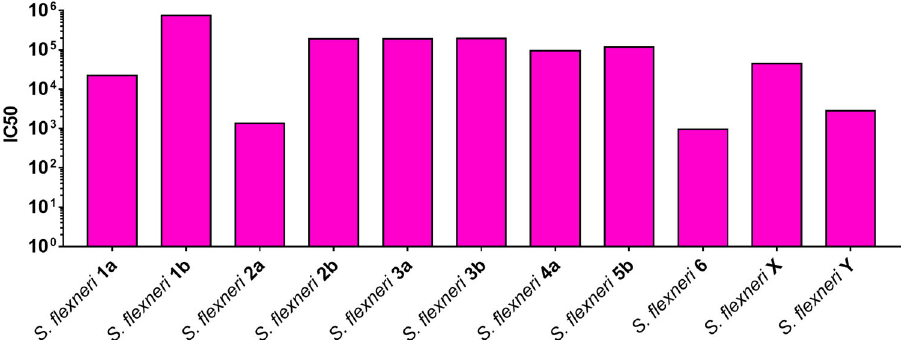
Fig. 5 Assessment of cross-reactivity induced by the hybrid 1 + 3 serotype. Bactericidal activity of sera raised in mice by GMMA displaying hybrid 1 + 3 serotype against a panel of the most epidemiologically relevant S. fl exneri serotypes. Pooled sera dilutions able to kill 50% of bacteria in the assay (IC50) are